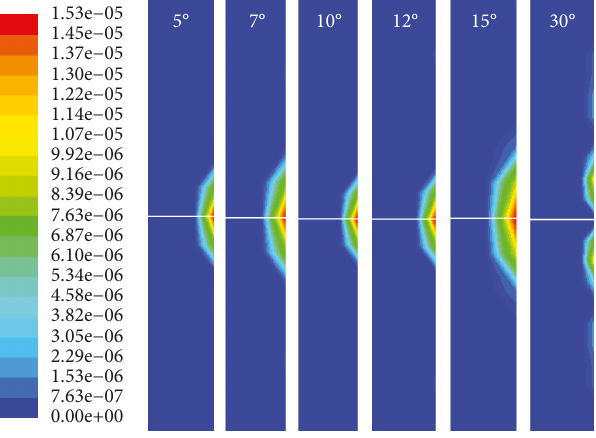
Figure 8: Erosion rate of rock at di ff erent divergent angles. Table 6: Erosion rates of rock at di ff erent throat aspect